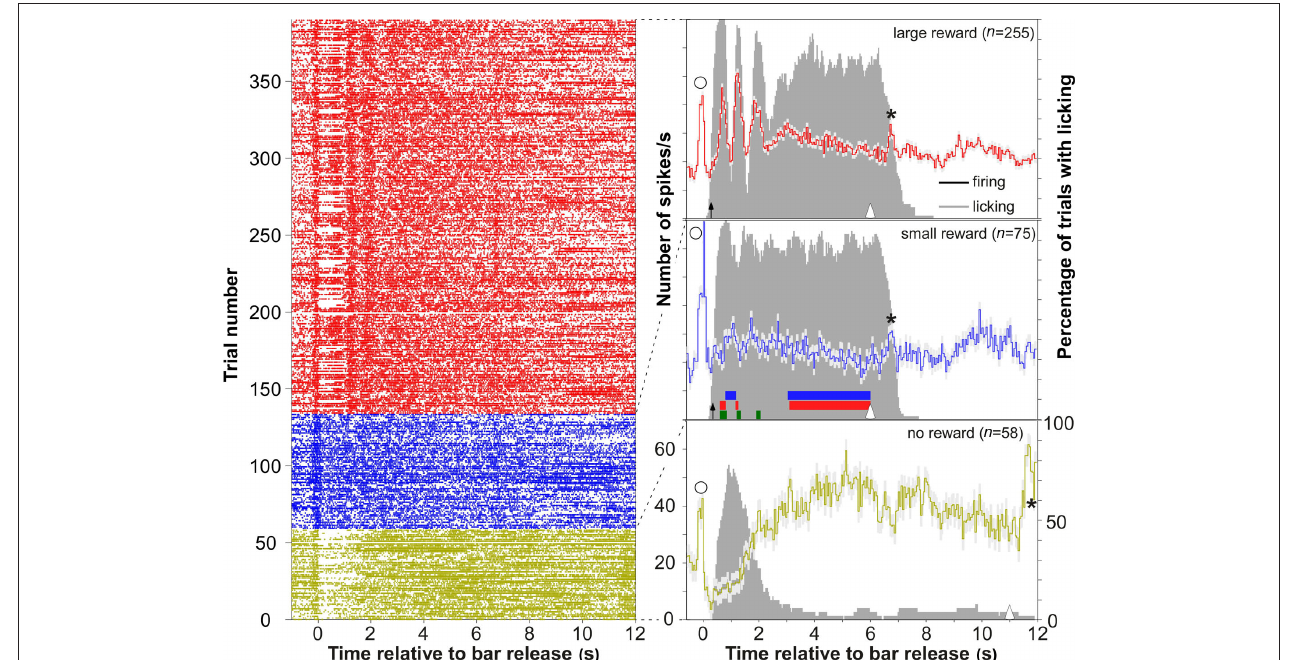
no). Conventions: solid arrows, reward onset (arrival of water); open arrows, onset of the next trial (illumination of LED); stars, firing that was related to bar grasping; open circles, firing that was related to bar release. The gray-bar histograms show the percentage of trials in which the water spout was licked for the three reward conditions (right ordinate). Licking activity was determined by videoing during task performance (25 fps; Sony CCD-F375E video tape). The monkey’s tongue being outside its mouth and touching the water spout was considered as